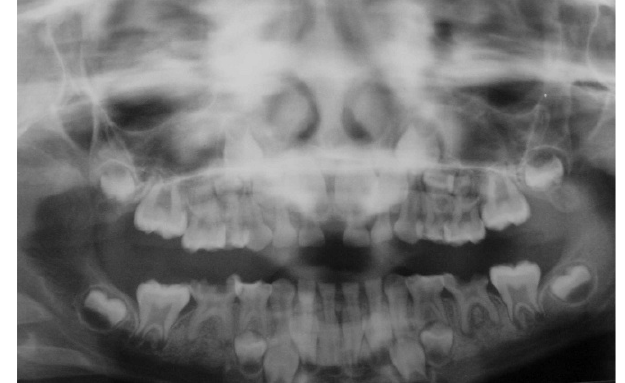
Figure 2 - Panoramic radiograph of a 7-year-old patient at diagnosis who was submitted to chemotherapy and 2,100 cGy irradiation. Note agenesi of the lower right second premolar, taurodontism of the first permanent molars and microdontia of the upper and lower left